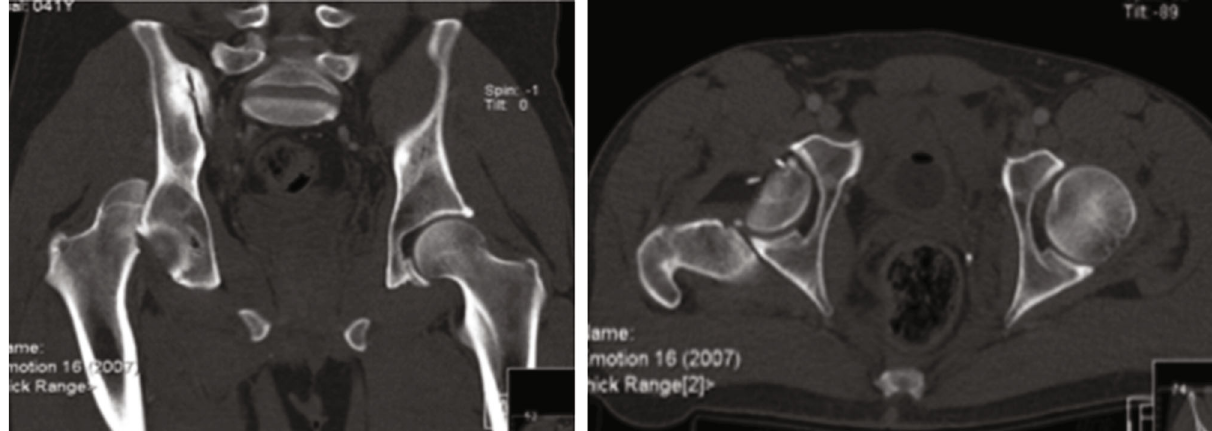
Figure 1: CT-scan of the pelvis showing a femoral head fracture associated with a posterior hip dislocation.